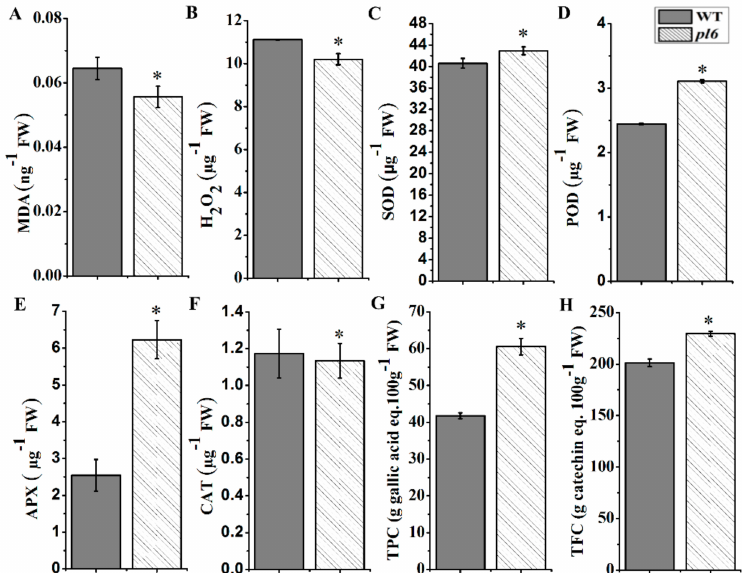
Figure 7. Antioxidant activity and oxidative damage between the WT and the pl6 mutant. ( A ) SOD (superoxide dismutase); ( B ) APX (ascorbate peroxidase); ( C ) POD (peroxidase); ( D ) CAT (catalase); ( E ) TFC (total flavonoid contents); ( F ) TPC (total phenolics content); ( G ) H 2 O 2 hydrogen per oxide; ( H ) The MDA (malonaldehyde) contents. All values are mean ± SD of three biological repeats. * p < 0.05 followed by Tukey’s